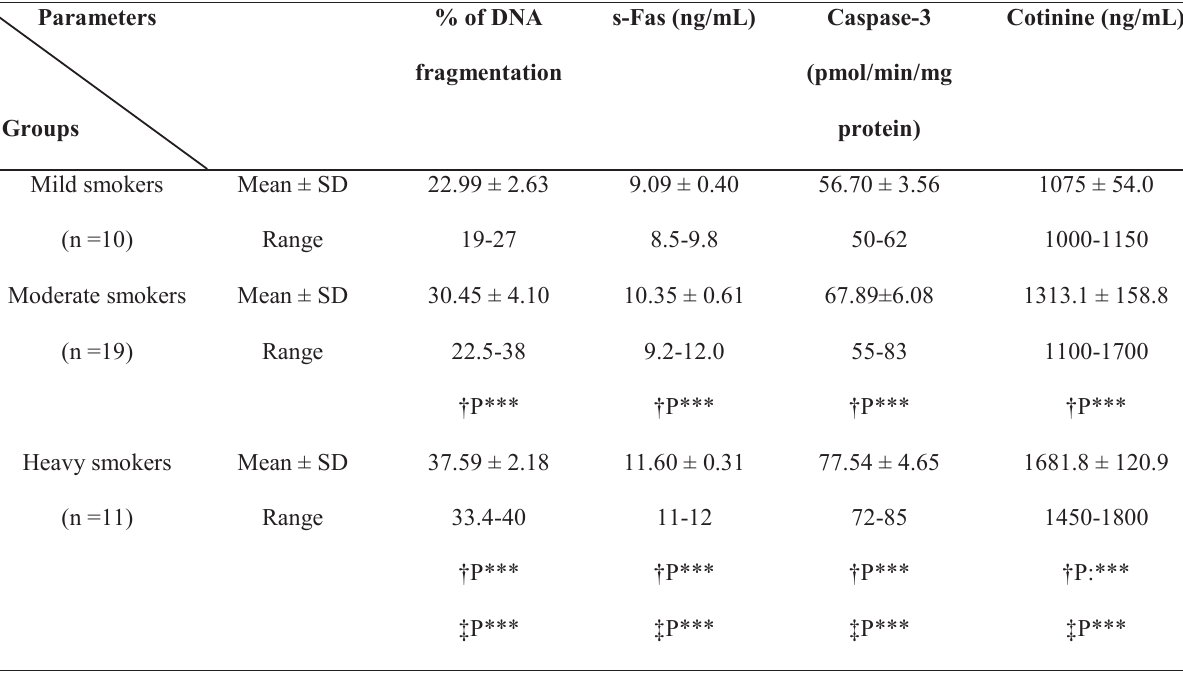
Table 4 - Seminal plasma levels of % of DNA fragmentation, s-Fas, Caspase-3 activity and cotinine in infertile men according to smoking status.